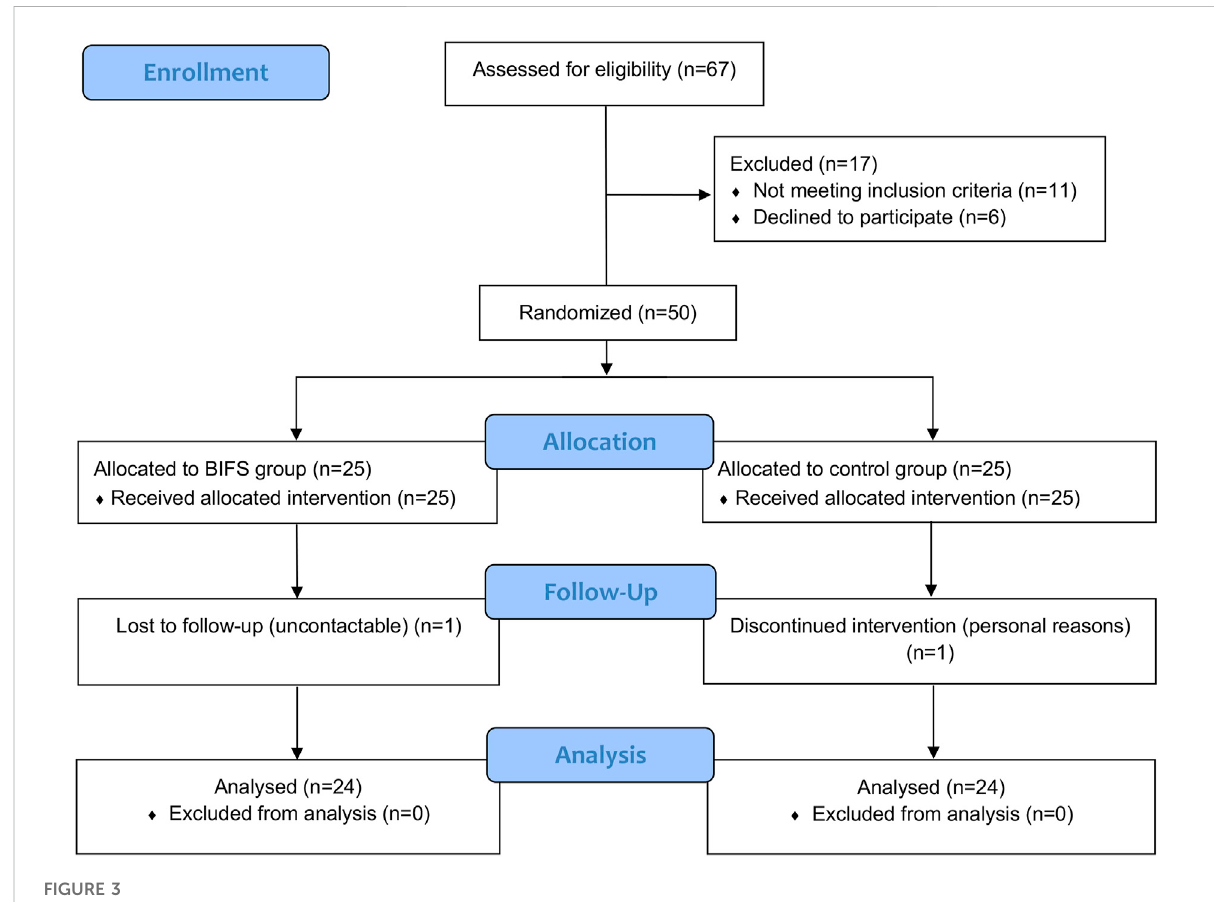
FIGURE 3 CONSORT fl ow diagram.